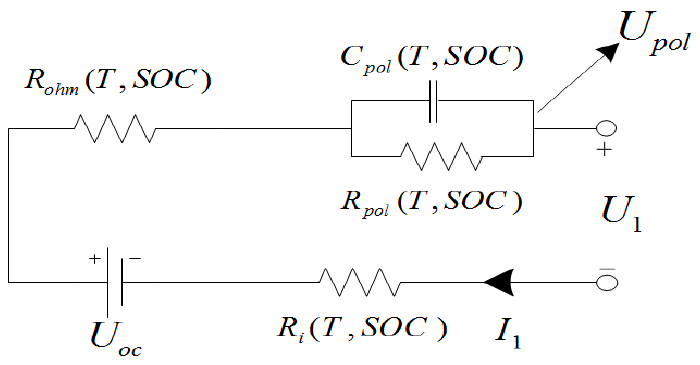
Figure 1. Variable parameter Thevenin model. SOC, state of charge.